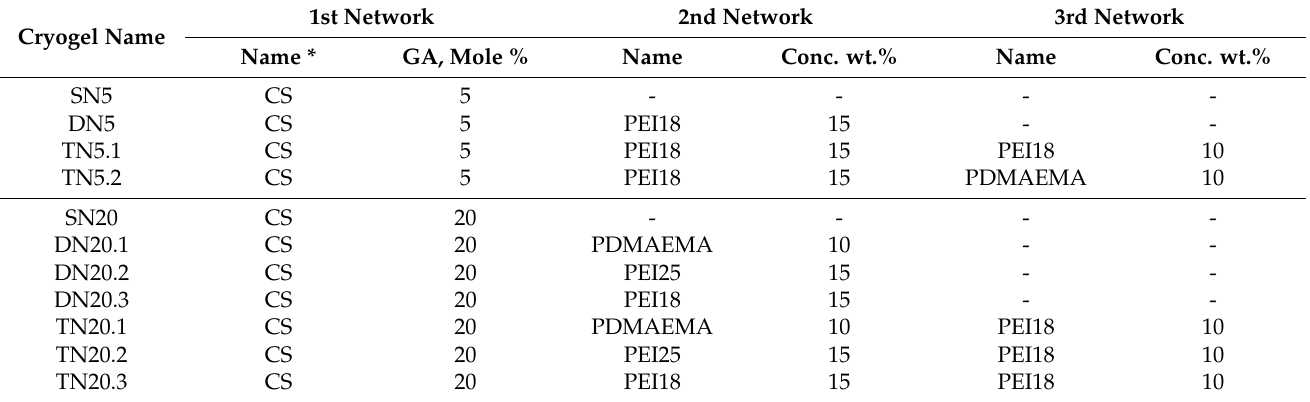
Table 1. Double-network (DN) and triple-network (TN) cryogels prepared and used as sorbents for the removal of Cr 2 O 72 − and H 2 PO 4 −